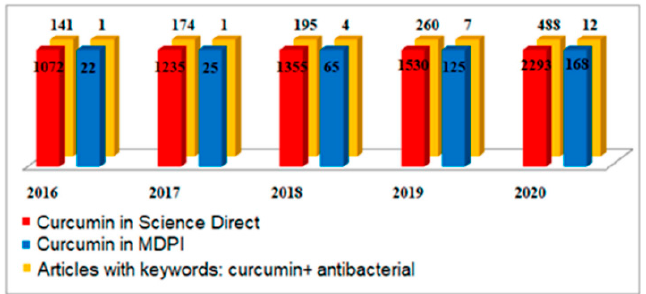
Figure 1. Total number of articles on “curcumin”, published between 2016 and 2020, in different databases.